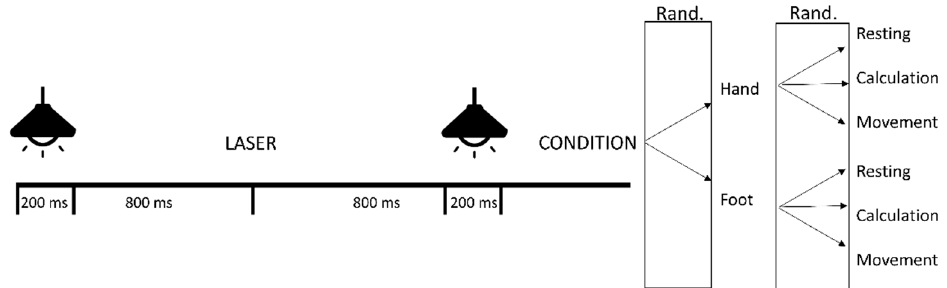
Figure 1. Graphic representation of the experimental setup. A visual stimulus of 200 ms preceded the nociceptive laser stimulus. After 800 ms, a second visual stimulus was provided. The second visual stimulus was followed by a resting period, a movement preparation task or a calculation task (randomised order). Abbreviations: rand: randomisation.